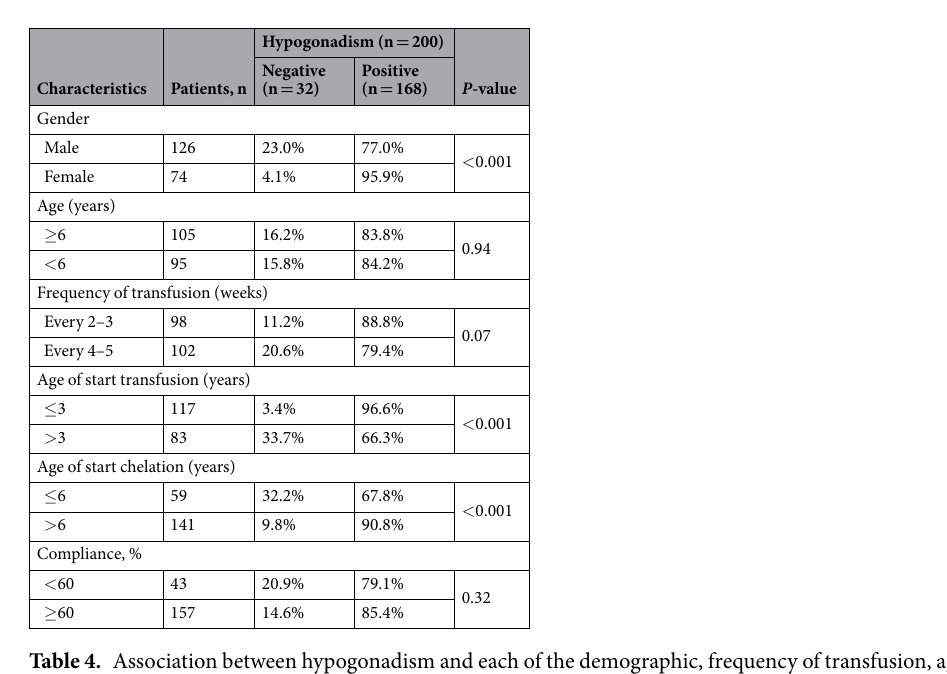
Table 4. Association between hypogonadism and each of the demographic, frequency of transfusion, age of start transfusion, Age of start chelation,